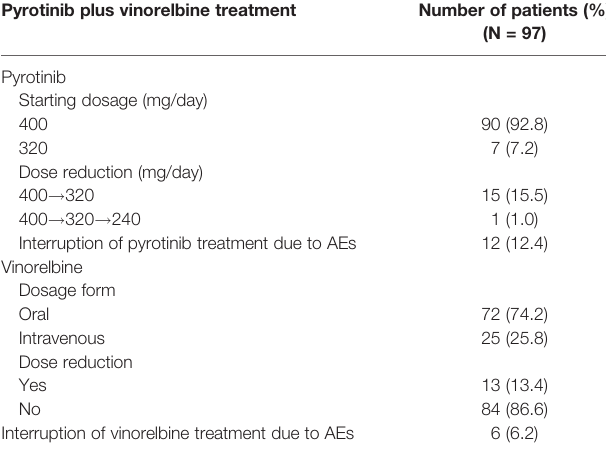
TABLE 2 | Treatment administration.